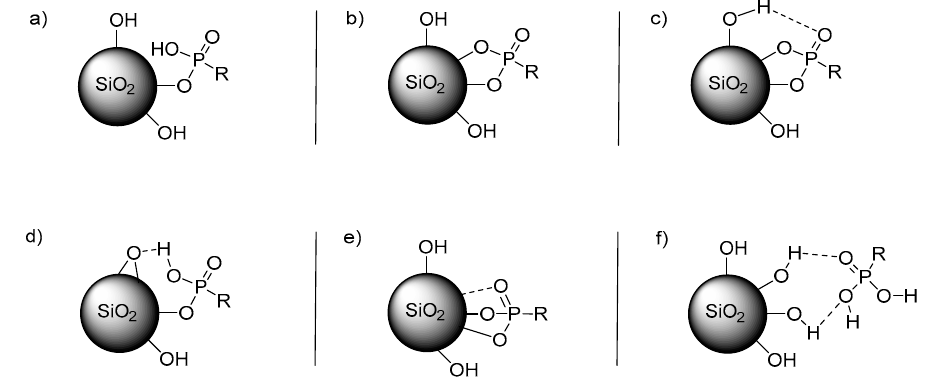
Figure 3. Possible types of attachment of a phosphonic acid to SiO 2 : ( a ) monoester; ( b ) diester; ( c ) diester with hydrogen bonding to a silanol group; ( d ) monoester with hydrogen bonding to a surface oxygen atom; ( e ) diester with Lewis acid/base interaction with a silicon atom; ( f ) pure hydrogen bond interactions.